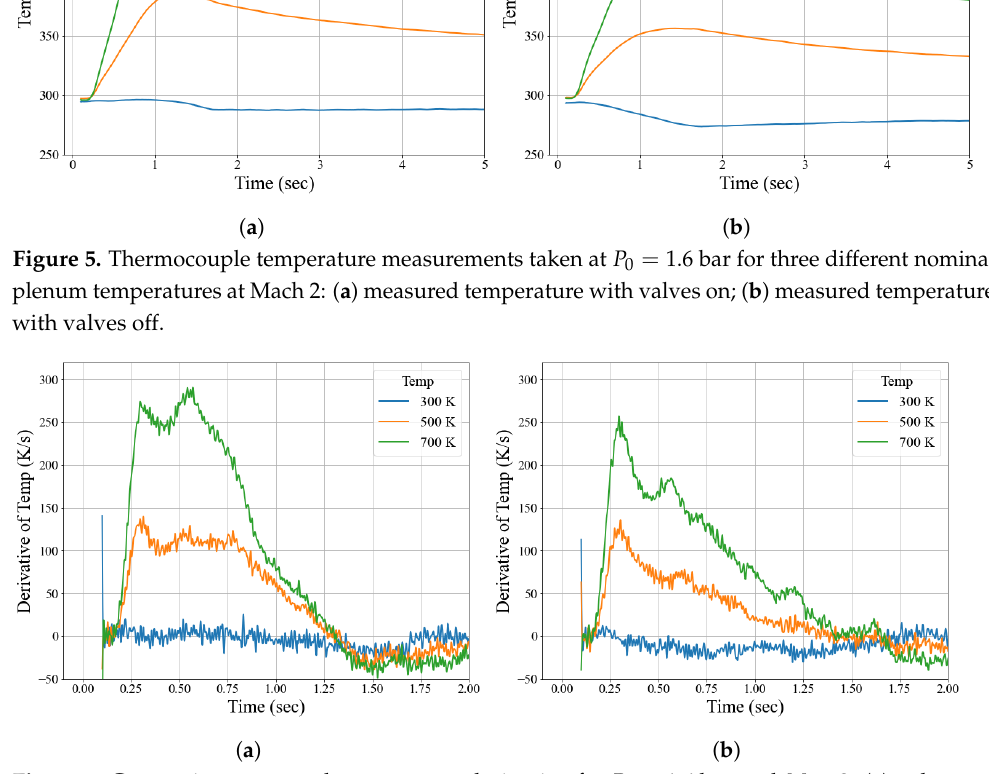
Figure 6. Comparing measured temperature derivative for P 0 = 1.6 bar and M = 2: ( a ) valves on; ( b ) valves